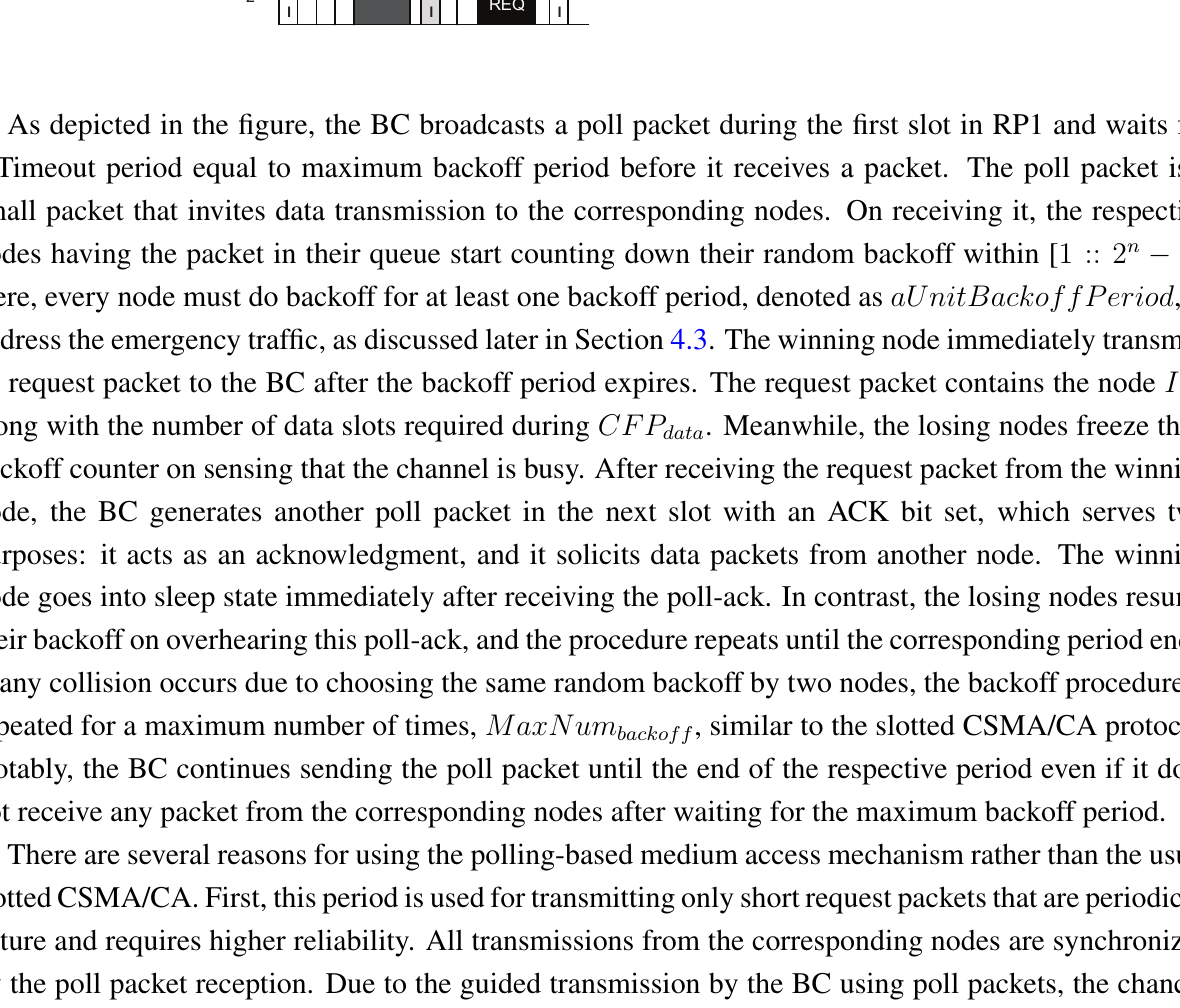
Figure 3. Medium access during CAP